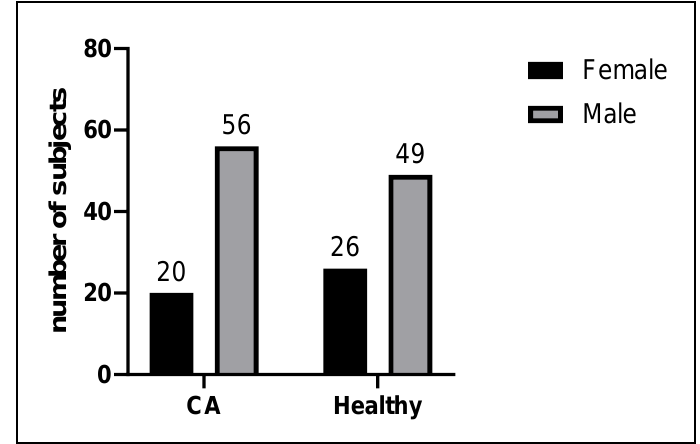
Figure A2. Sex distribution. Abbreviations: CA: cardiac arrest.